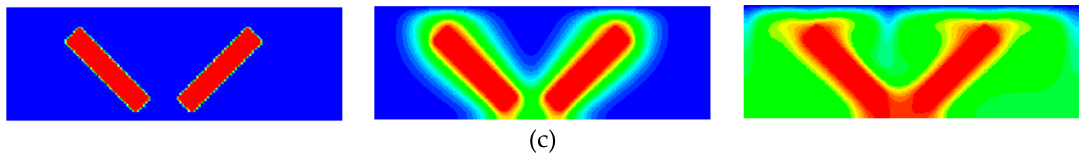
Figure 16. Time-dependence of isothermal contours for two values of heated-fin lengths L 1 = L 2 = 0.3, 0.5 and 0.9 at an inclination angle γ 1 = 45 and γ = 0.1. ( a ) L 1 = L 2 = 0.3; ( b ) L 1 = L 2 = 0.5; ( c ) L 1 = L 2 = 0.9 .